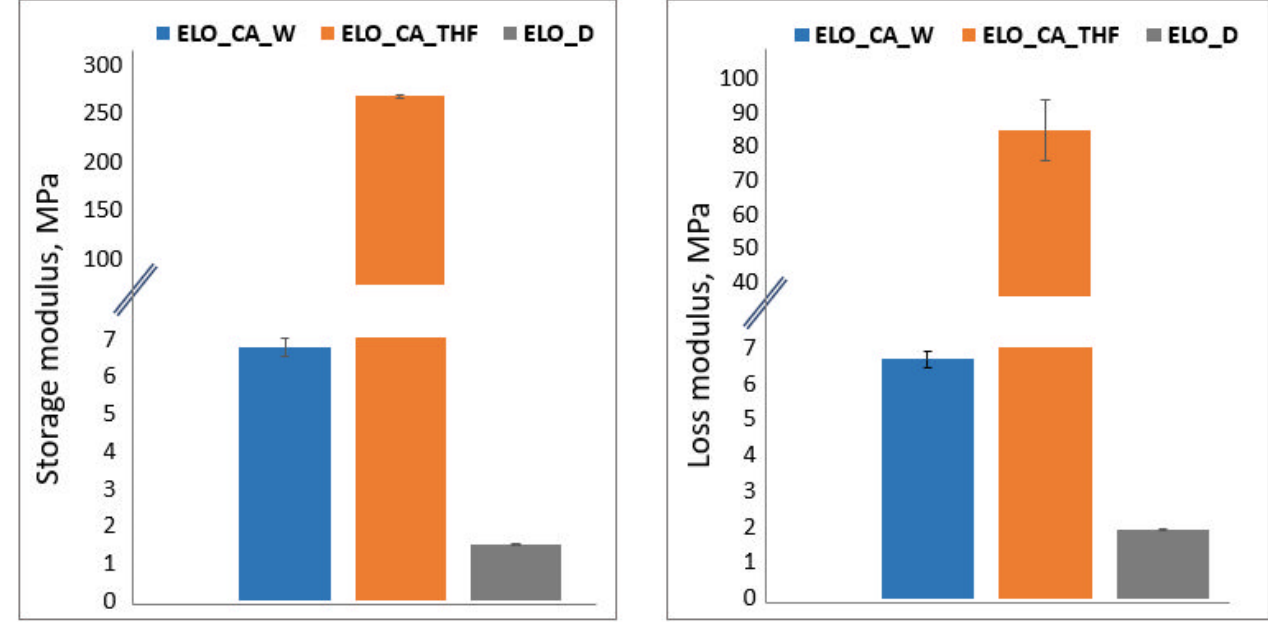
Figure 7. Storage and Loss Modulus data obtained through nanoindentation technique at 1 Hz.